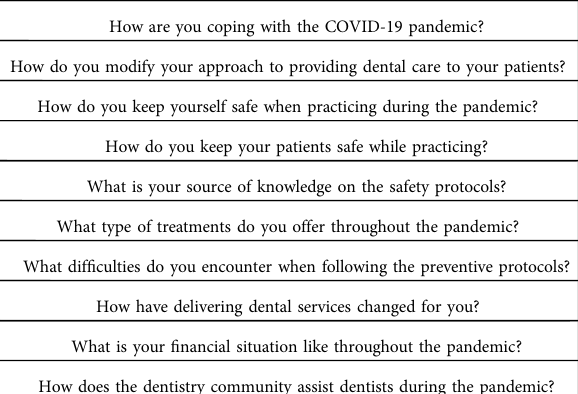
TABLE 1 The semi-structured interview